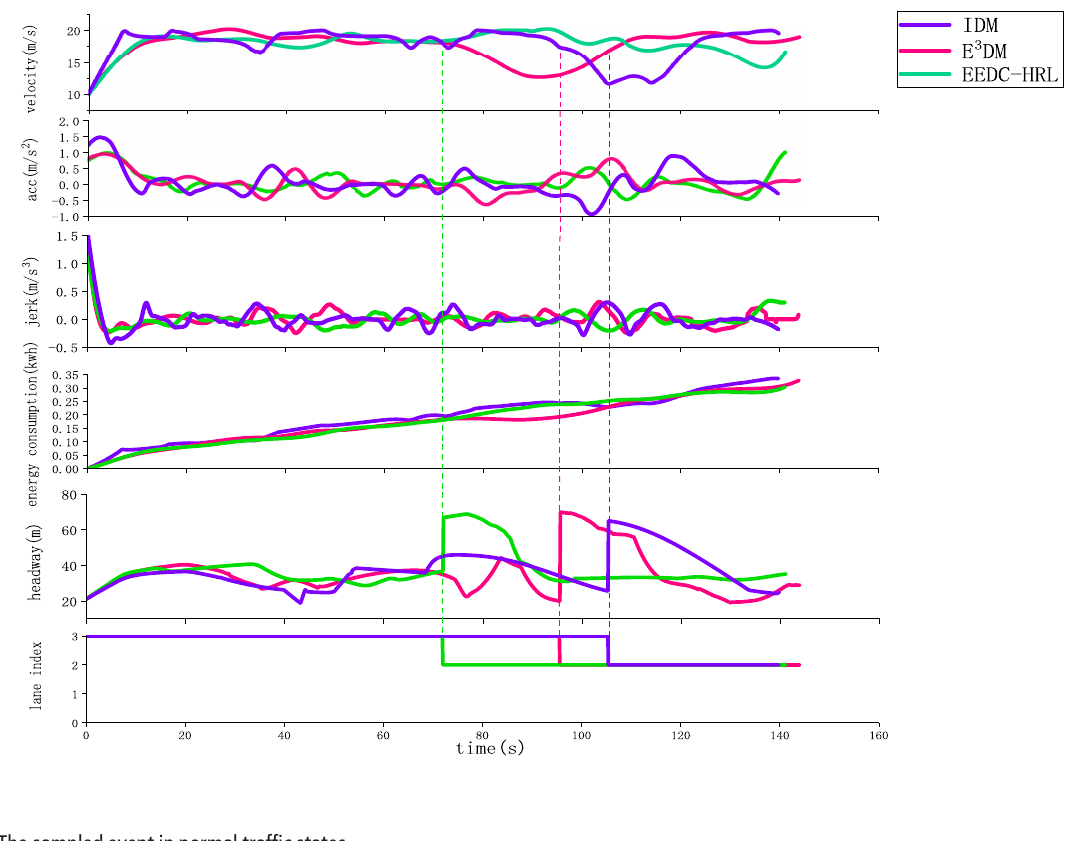
Figure 7 The sampled event in free traf fi c states